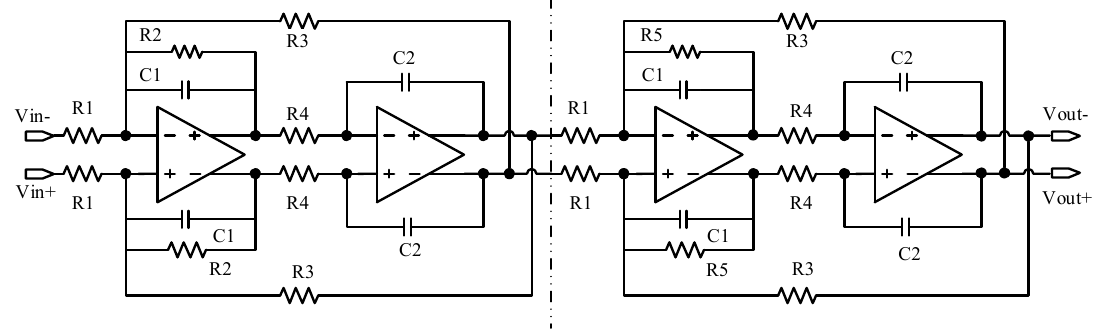
Figure 1. Schematic diagram of the presented LPF based on the Tow-Thomas biquads.